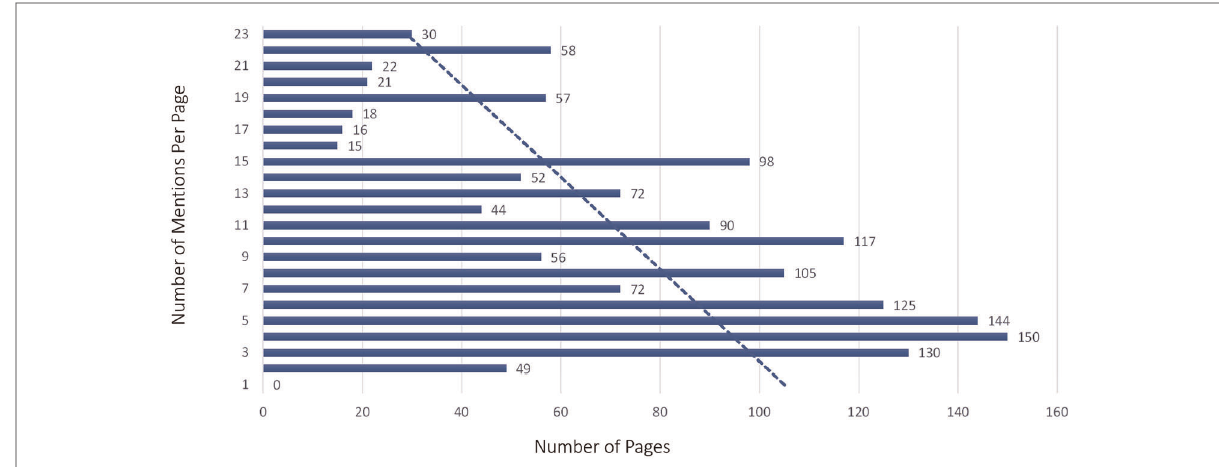
FIGURE 5 Body function mention frequency training sample by page.